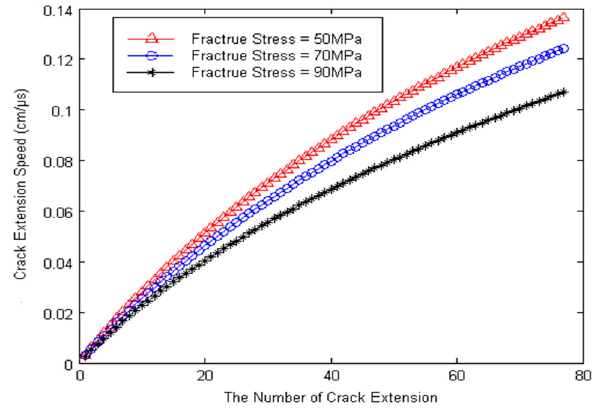
Figure 20. Different speed of extension verses different fracture stress.